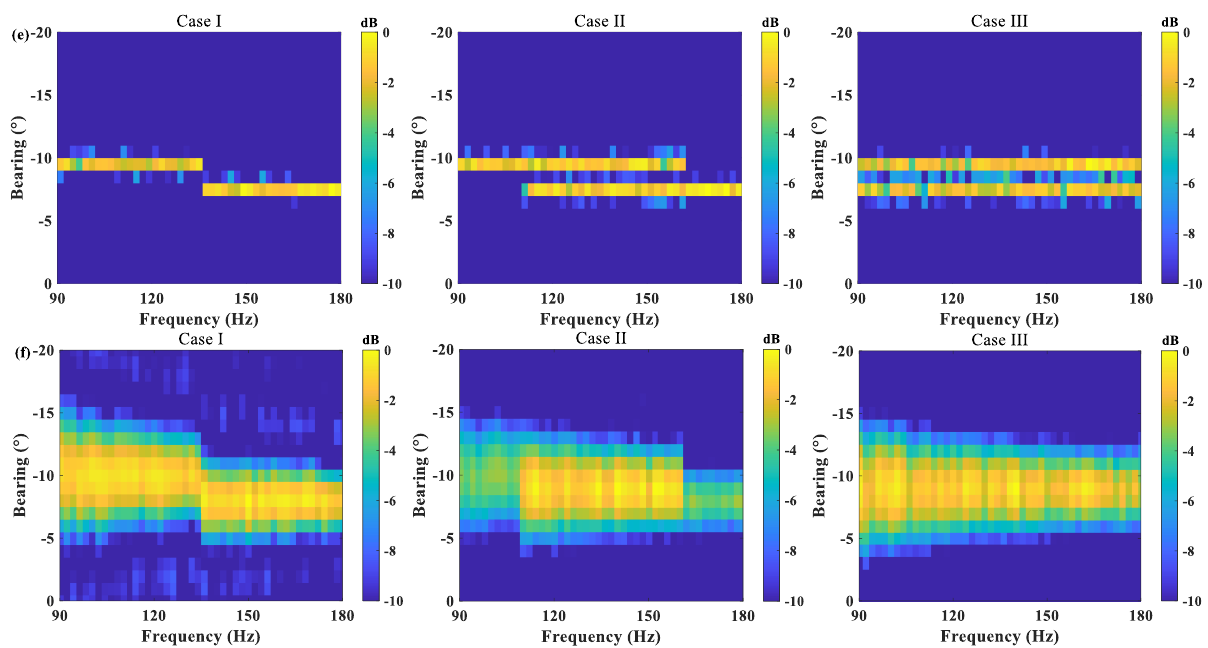
Figure 3. ( a ) The true space – frequency map, as well as the estimation results of ( b ) the proposed method, ( c ) JP-WSBL, ( d ) IP-WSBL, ( e ) W-SpSF and ( f ) CBF.